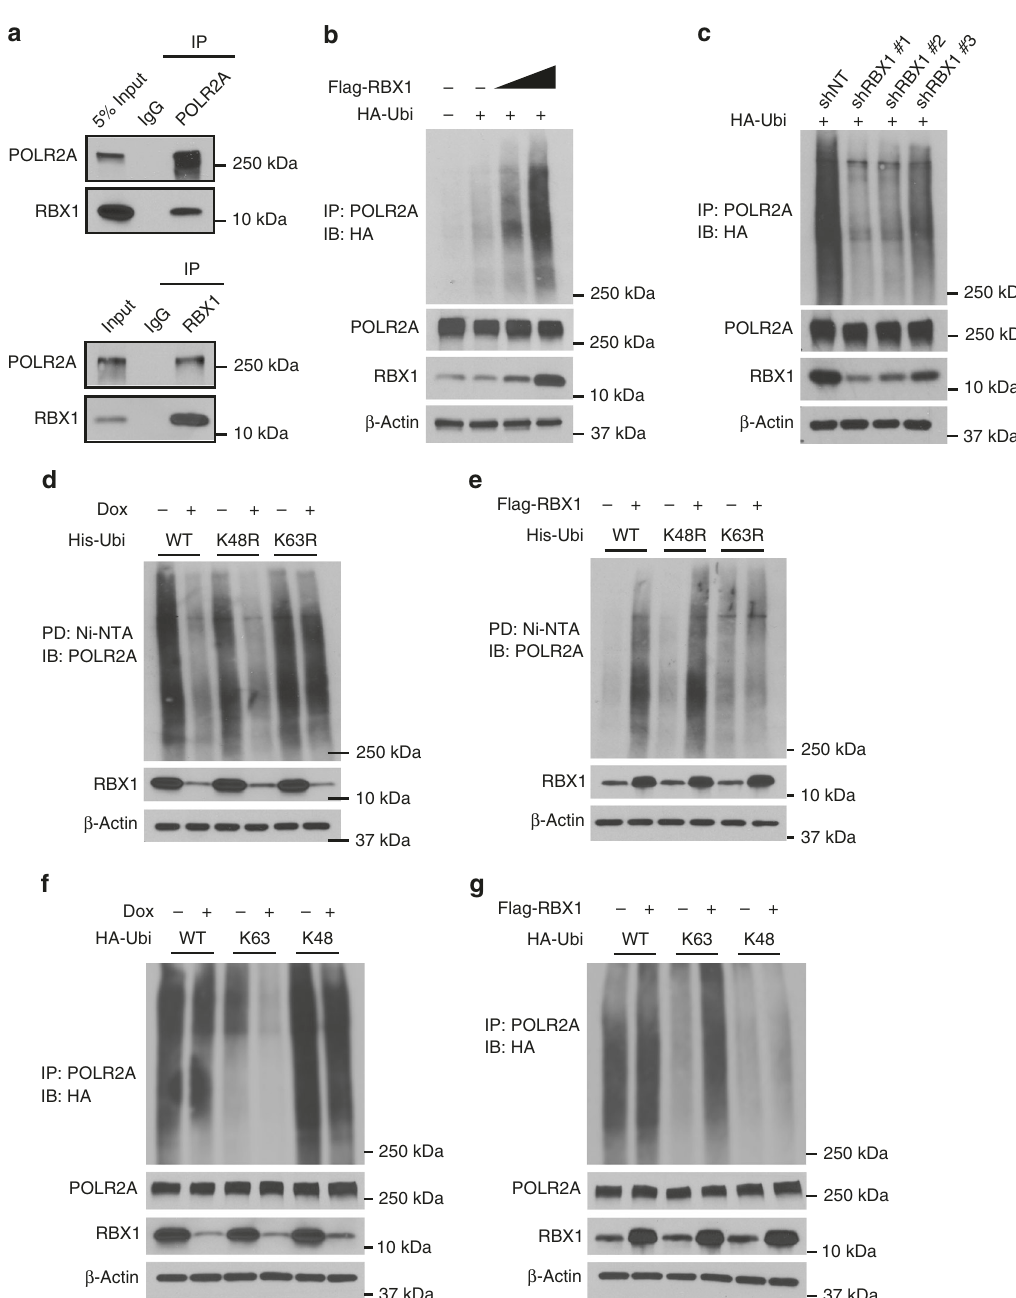
Fig. 5 RBX1 modi fi es POLR2A by the K63-linked ubiquitination. a RBX1 physically interacts with POLR2A. Immunoprecipitation (IP) and western blot analyses were performed using indicated antibodies. Normal IgG was used as a negative control for IP. b , c RBX1 overexpression ( b ) or knockdown ( c ) increases or decreases the level of ubiquitinated POLR2A, respectively. DU145 cells transfected with indicated expression vectors were treated with MG132 and ubiquitinated POLR2A was pulled down (IP) and subject to immunoblotting (IB) analysis. d , e RBX1-mediated ubiquitination acts on the lysine- 63 (K63) residue of POLR2A. DU145 cells were transfected with the indicated ubiquitin expression vectors and treated with MG132. Cells were also treated with Dox to induce RBX1 knockdown in d , or ectopic Flag-RBX1 was expressed in the cells in e . Ubiquitinated POLR2A was pulled down (PD) with